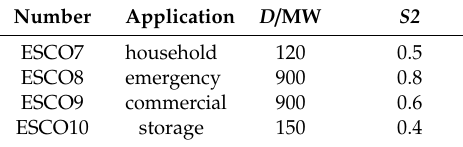
Table 3. Sell nodes in the EBN.